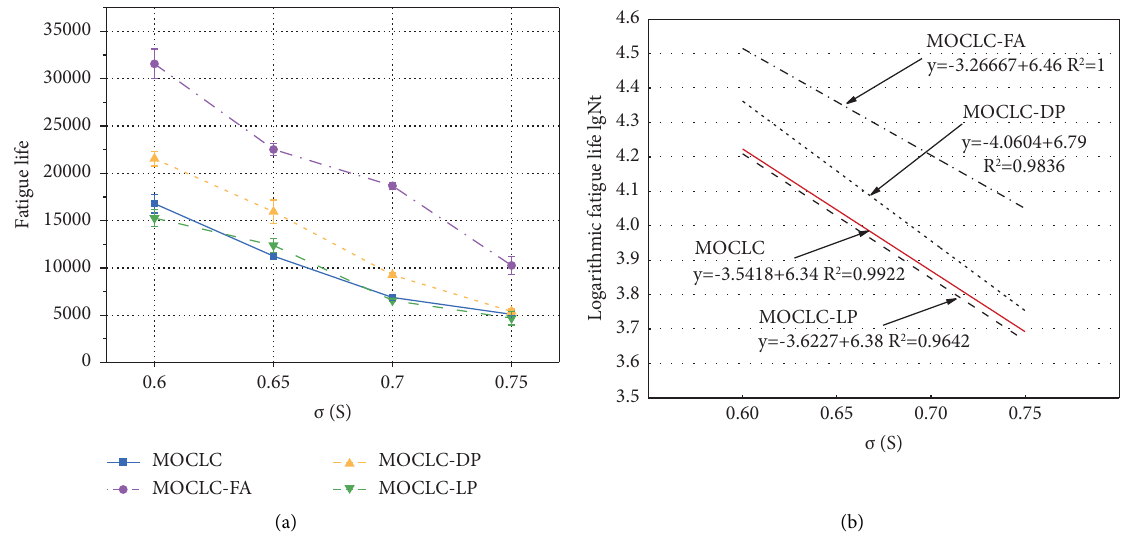
Figure 13: Comparison of MOCLC fatigue life under diferent mineral